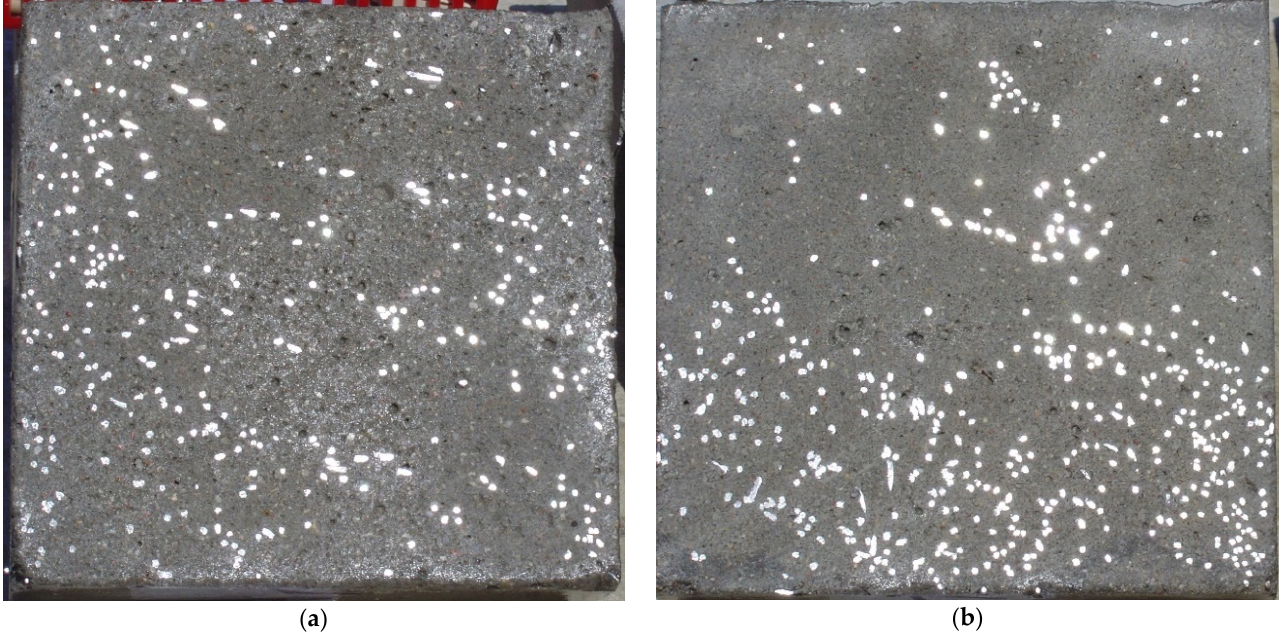
Figure 1. Cross ‐ sections of tested SFRC cubic specimens differentiated by vibration time and consistency: ( a ) t vib = 20 s, t Vebe = 7 s, ( b ) t vib = 240 s, t Vebe = 2 s.